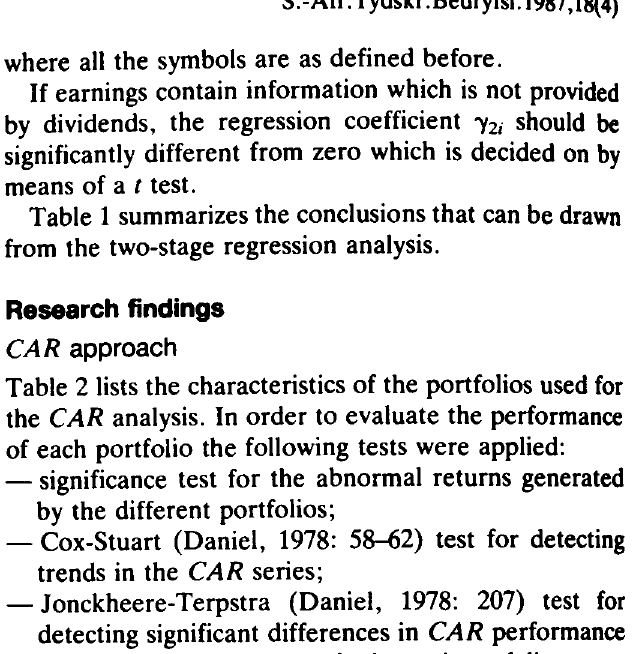
Table 1 Summary of conclusions to be drawn from the two-stage regression analysis